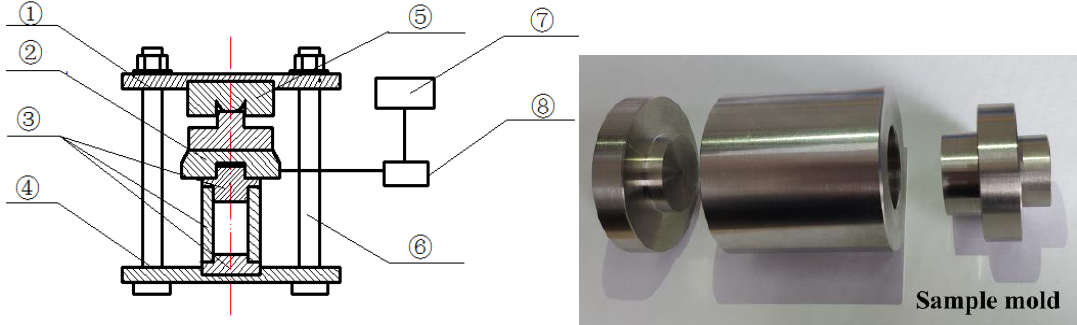
Figure 3. Schematic diagram of the expansion stress testing apparatus ( ① : top plate; ② : sensor; ③ : sample mold; ④ : bottom plate; ⑤ : anti-load measuring head; ⑥ : constrained screw; ⑦ : data acquisition system; ⑧ : transmitter.).